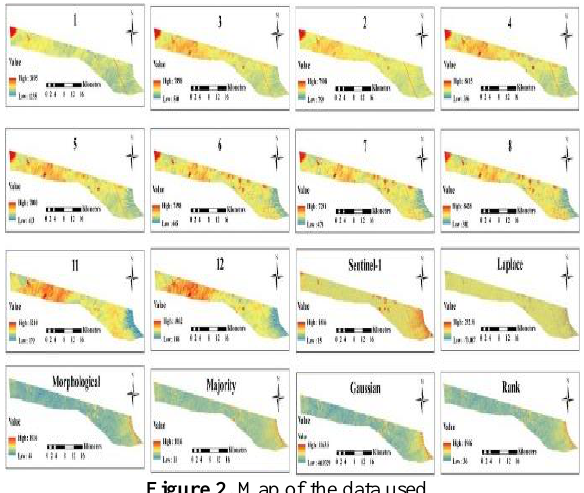
Figure 2. Map of the data used. The graph of determination coefficients (R2) and line equation (regression formula) of the data used were obtained. Figure 3 is variable models used and a graph of the coefficient of determination of Sentinel2 bands in the next step, which is provided in table 2. According to the models used in figure3, y is the dependent variable for each band of Sentinel-2, and x is the soil moisture percentage obtained using each band of sentinel-2.